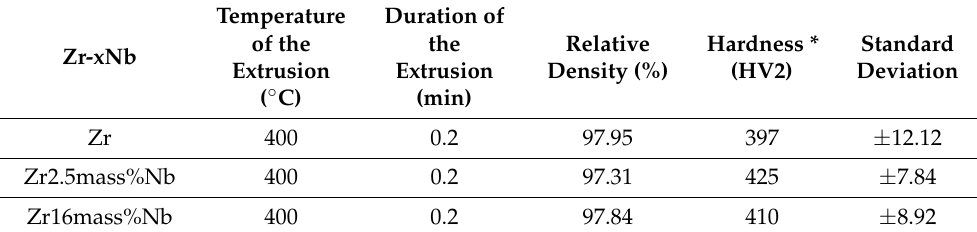
Table 4. The SPS process parameters, relatively densities, hardness of the sintered Zr-xNb materials obtained from mixtures with the 44 µ m average size of niobium powder, milled in water. Duration of Sintering Relative Hardness * Standard the Sintering Zr-xNb Temperature Density (%) (HV2) Deviation (min) ( ◦ C) Zr1mass%Nb 1200 1 94.97 357 ± 2.13 Zr2.5mass%Nb 1200 1 95.49 375 ± 3.31 Zr16mass%Nb 1200 1 95.07 382 ± 15.93